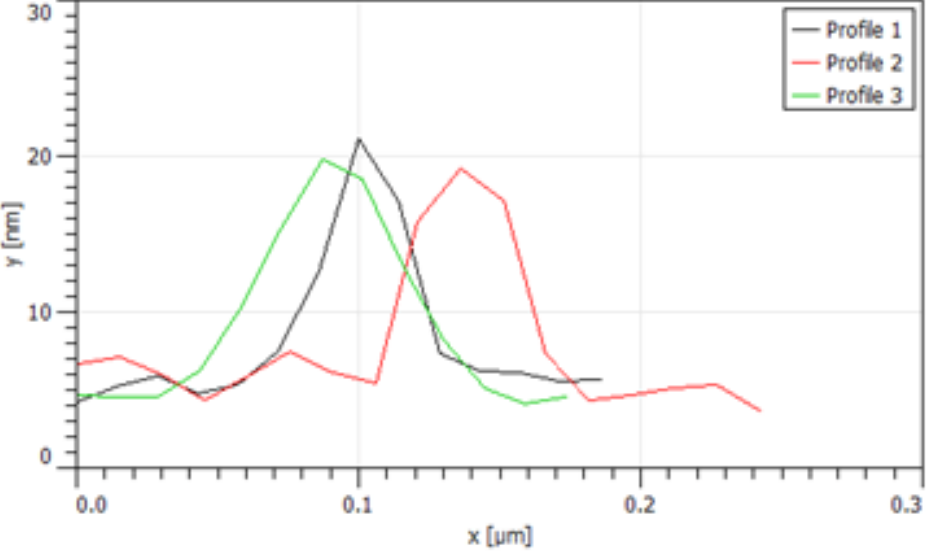
Figure 2. Three traces of the nanoparticle diameters collected via atomic force microscopy. The NPs are shown to be around 60 nm in diameter.